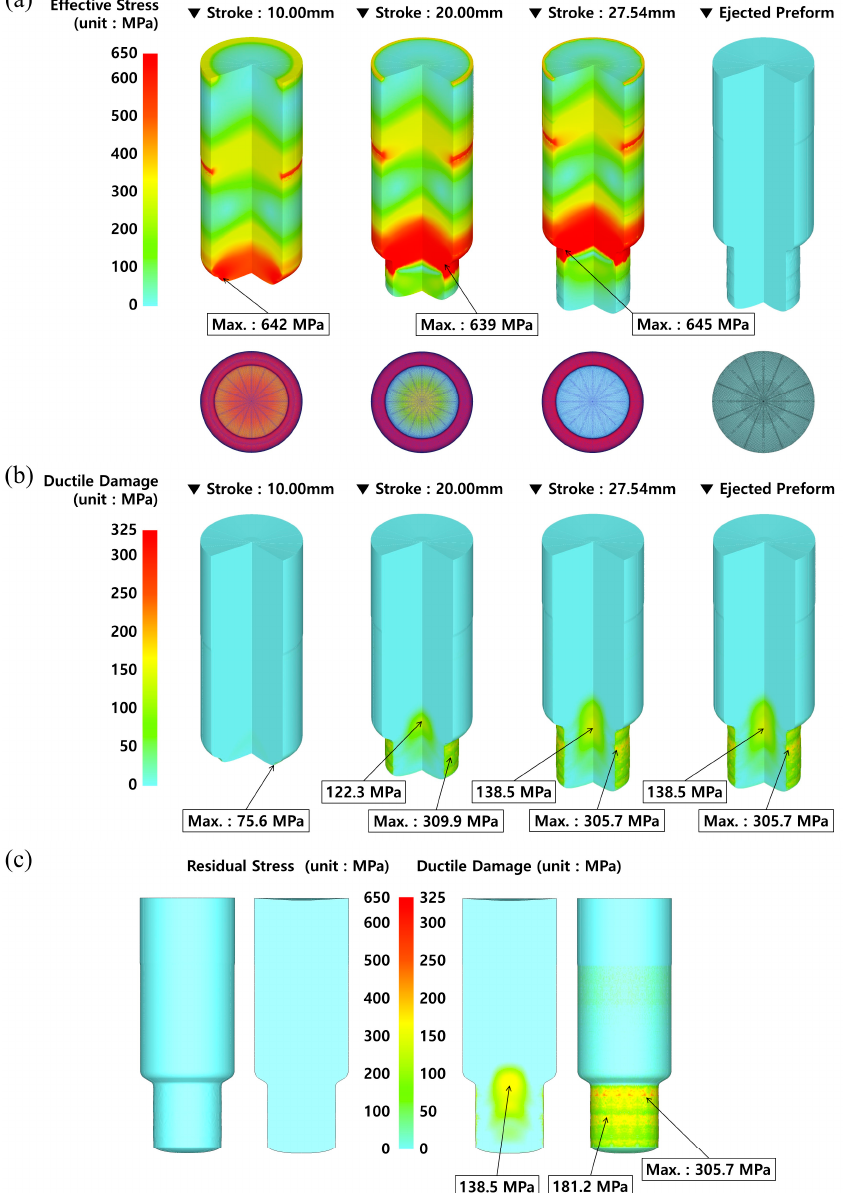
Figure 9. Numerical simulation results in the case where plastic material model was applied: ( a ) effective stress distribution; ( b ) plastic deformation damage distribution; ( c ) distribution of residual stress and plastic deformation damage after preform ejection.